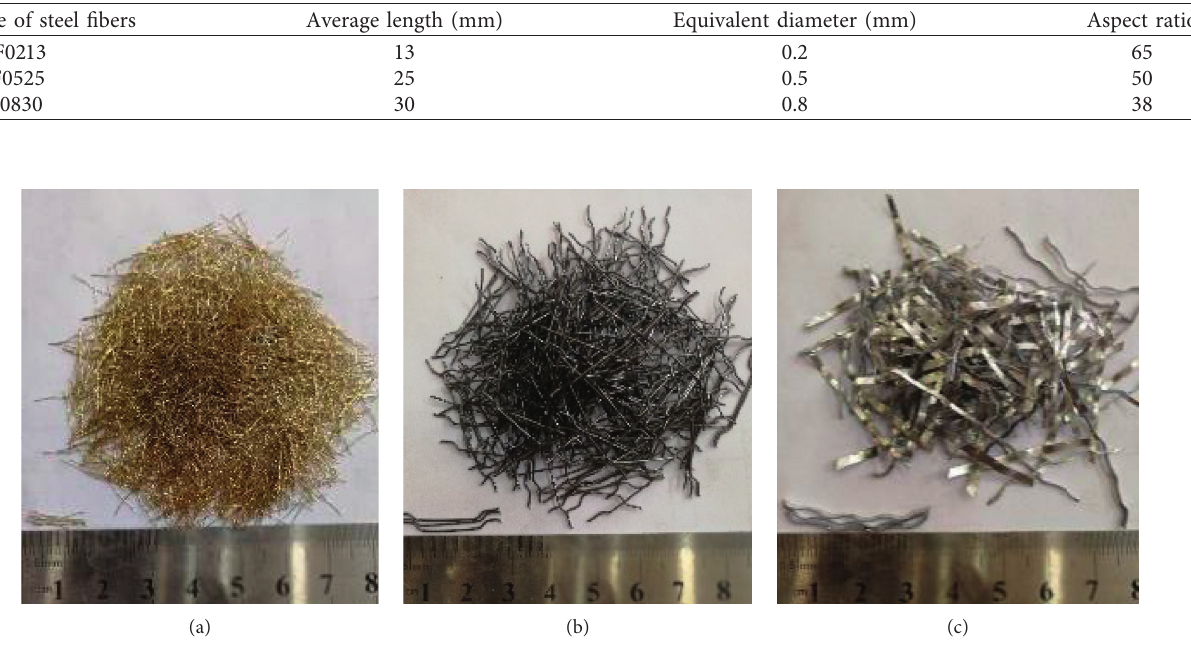
Table 2: Characteristic parameters of steel fibers.